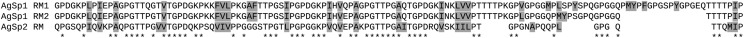
Predicted amino acid sequence of repeat motif 1 (RM1) and repeat motif 2 (RM2) from AgSp1 aligned with the predicted amino acid sequence of the repeat motif (RM) from AgSp2 of A. trifasciata. Conserved residues are marked with an asterisk below, and hydrophobic residues are highlighted.